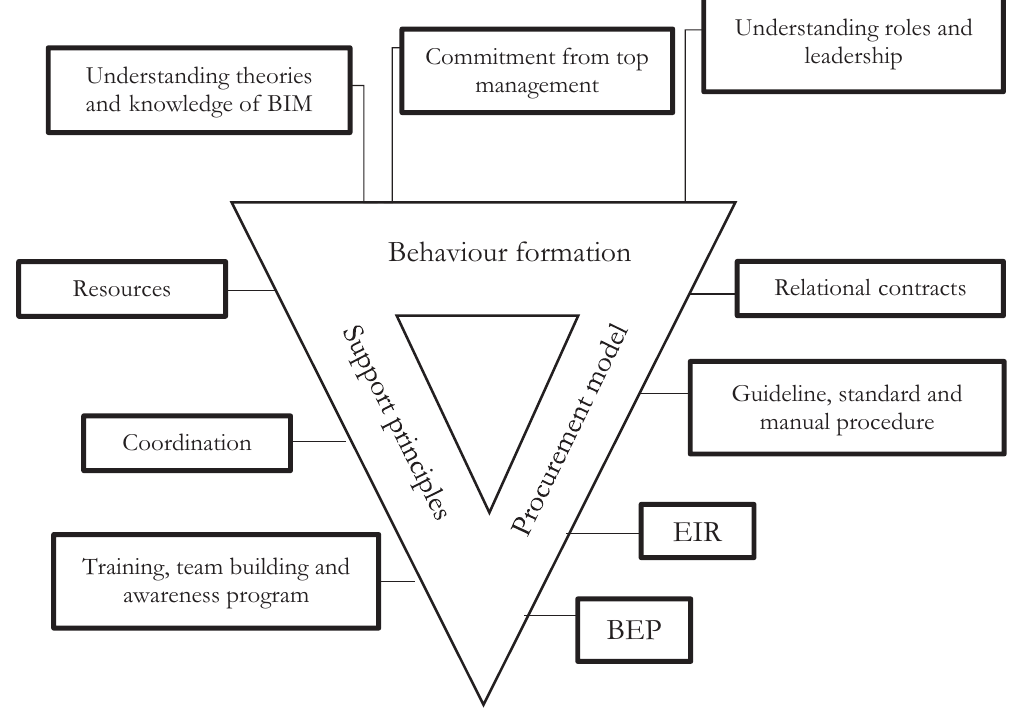
Best practice approach influencing social collaboration among multi-actors in BIM Level-2